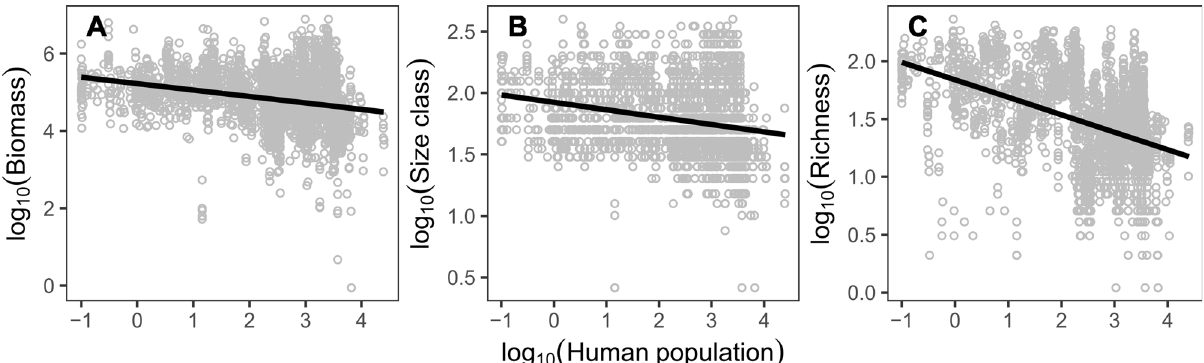
Fig. 4 Human population size predicts aspects of fi sh community structure. Proximity to high densities of humans is associated with: A reduced total fi sh community biomass; B smaller observed median size classes; and C fewer species. Lines are predicted trends from generalized linear models.